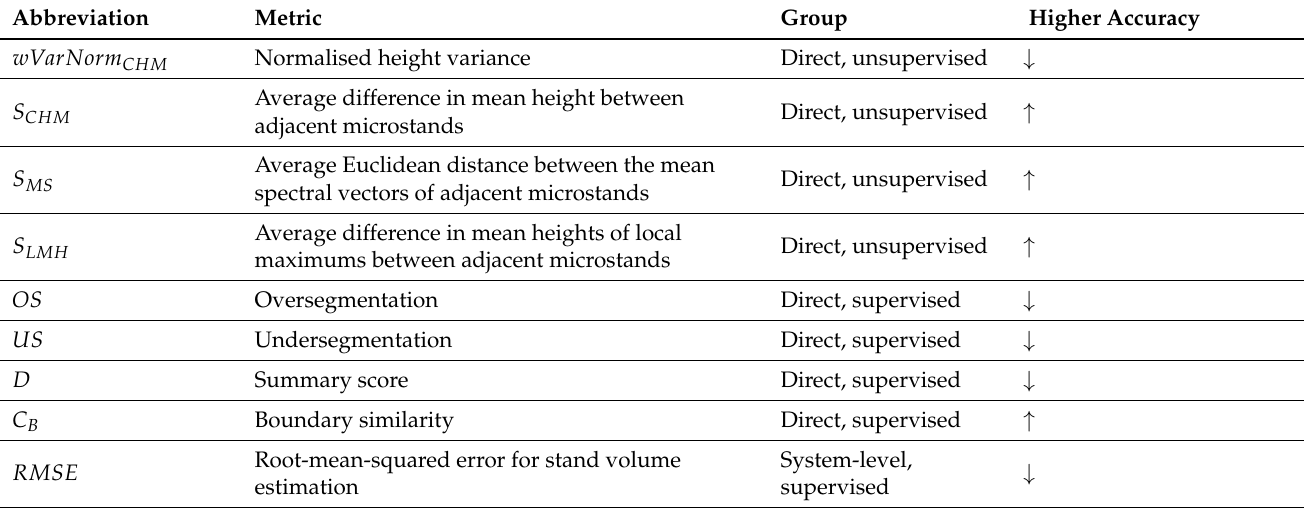
Table 2. Accuracy metrics employed in this study. The last column shows if a higher or lower value indicates better segmentation: —a higher metric value indicates higher quality, ↑ value indicates higher